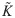
Unsuccessful implementations of Besag’s edge correction term at non-binary fields of view (K˜ with respect to radius at different event densities).The normalized and centered K-function (K˜), as described by Lagache et al, was calculated at different particle intensities and radii using simulated square fields of view measuring 256 x 256 pixels, with a homogeneous Poisson distribution of particles (Complete Spatial Randomness). Densities are expressed in particles per pixel. The black line represents the mean K˜ and the dotted lines represent the upper and lower critical quantiles (Q01 and Q99). Each mean/quantile was determined using a set of 1000 simulations. Panel A: Applying Besag’s correction term only to edge pixels, by dividing the pixels within a given radius by the area of an ideal circle of the same radius. It can be seen that K˜ is no longer centered around zero at high particle intensities. Panel B: Same as panel A, but dividing by a pixelated circle rather than an ideal one. Like panel A, it can be seen that K˜ is no longer centered on zero at high intensities. Panel C: For comparison, K˜ was calculated without applying any edge correction terms. It can be seen that edge effects play a significant role at high particle intensities, making K˜ deviate remarkably from zero.